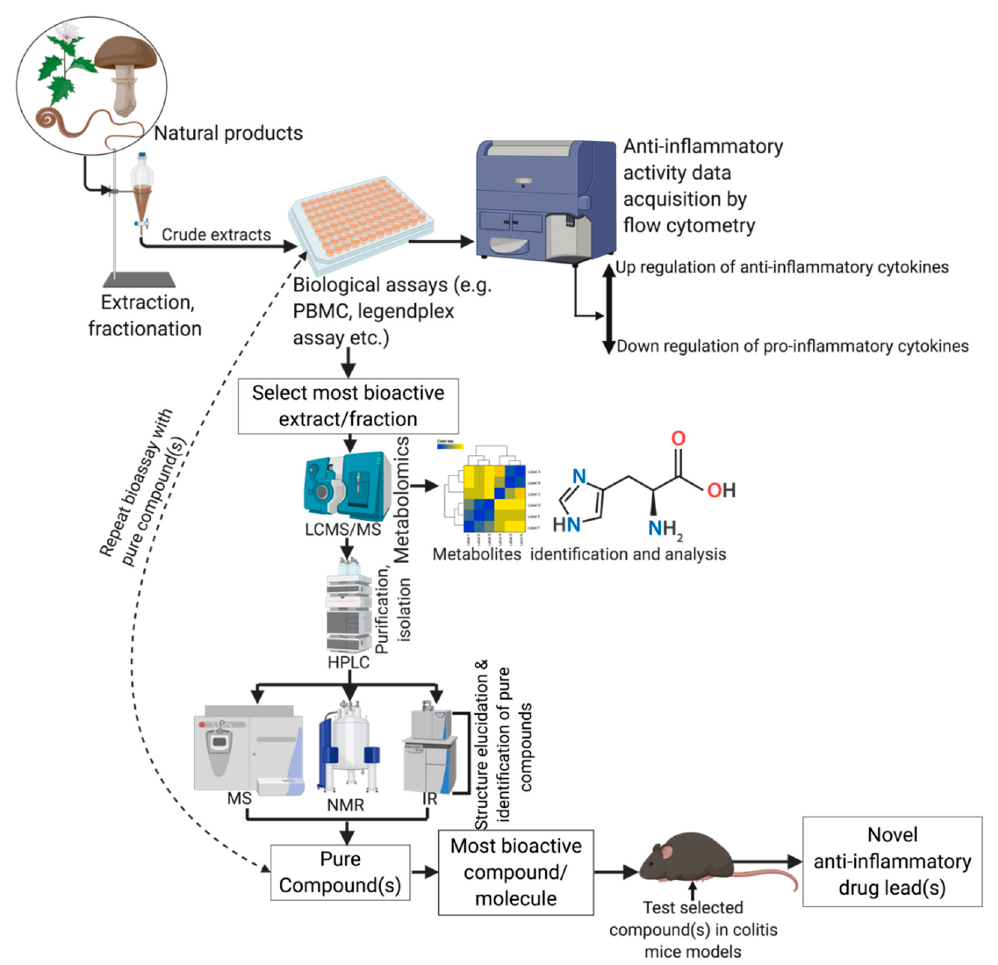
Figure 8. Schematic representation of the techniques used in anti-inflammatory drug-discovery from natural products. PBMC, peripheral blood mononuclear cell; LCMS, liquid chromatography mass spectrometry; MS; mass spectrometry; HPLC, high performance liquid chromatography; NMR, nuclear magnetic resonance; IR, infrared red.